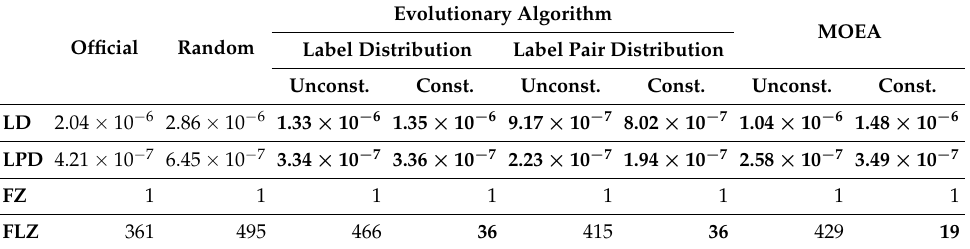
Table 12. Evaluation of the different splitting approaches of the OpenImages subset in the Tencent ML-Images database. In bold the results that are better than the official method, usually employed in the literature. NOTE: The results for the Stratification method are not shown as no result was obtained after 10 days of processing. Therefore, ED is not shown as it only deviates from zero for this method. Evolutionary Algorithm MOEA Official Random Label Distribution Label Pair Distribution Unconst. Const. Unconst. Const. Unconst.